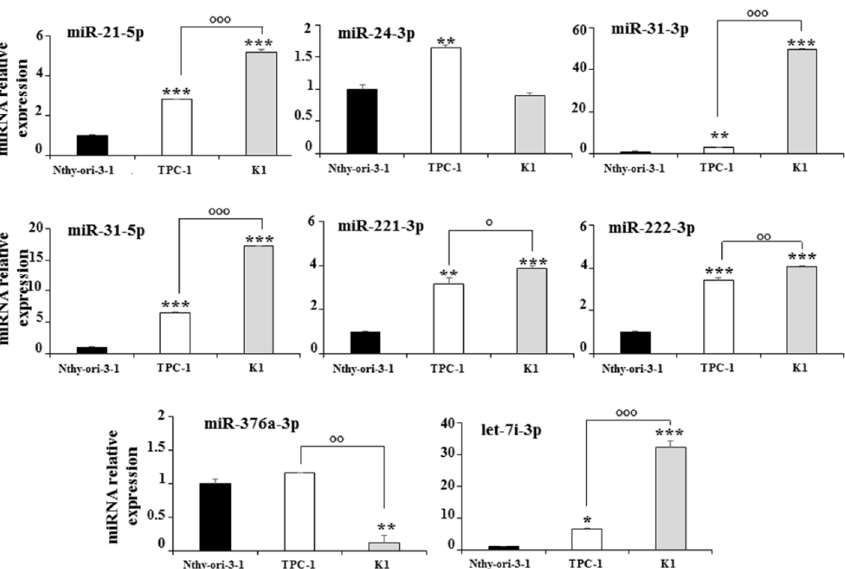
Figure 3. Expression levels of cellular miRNAs in Nthy-ori-3-1, TPC-1, and K1 cells; miRNA ex- pression levels are reported as the mean expression value of each PTC cell line and normalized to the mean expression of the Nthy-ori-3-1 cells (equal to 1). Error bars represent standard deviation; p -values were obtained by using one-way ANOVA with Tukey’s multiple comparison test: * p < 0.05, ** p < 0.01, *** p < 0.001 vs. Nthy-ori-3-1; ◦ p < 0.05, ◦◦ p < 0.01, ◦◦◦ p < 0.001 vs. TPC-1.